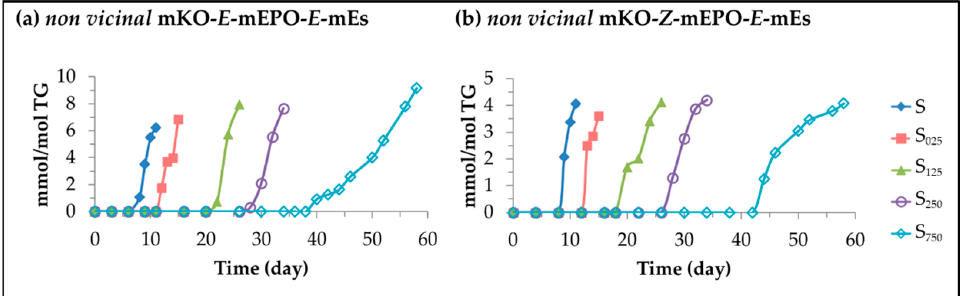
Figure 10. Evolution of the concentration expressed in mmol/mol TG, in samples S, S 025 , S 125 , S 250